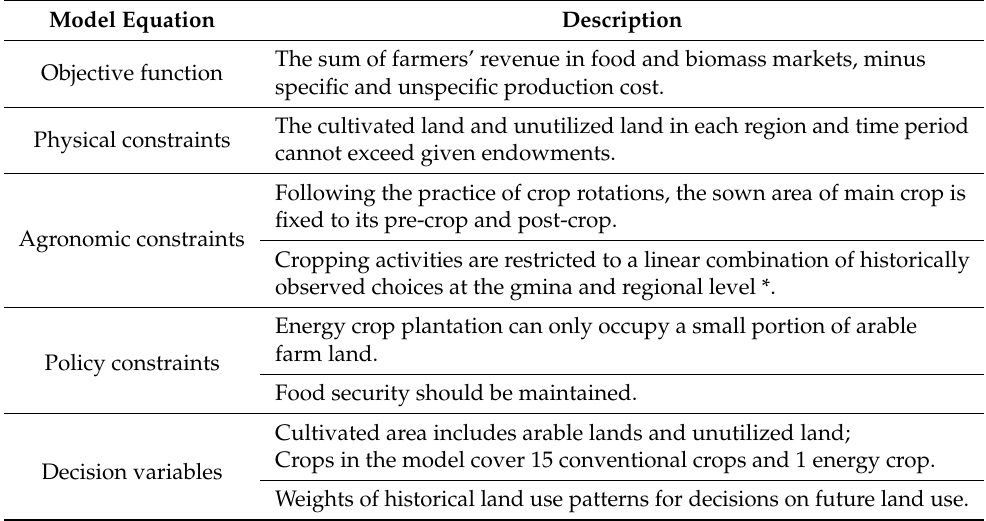
Table 1. Model equation and variable